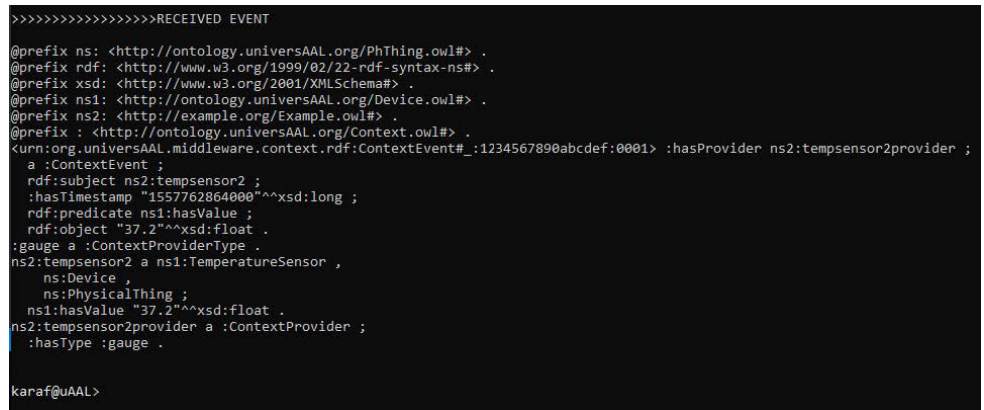
Figure 7. Event of data registration in